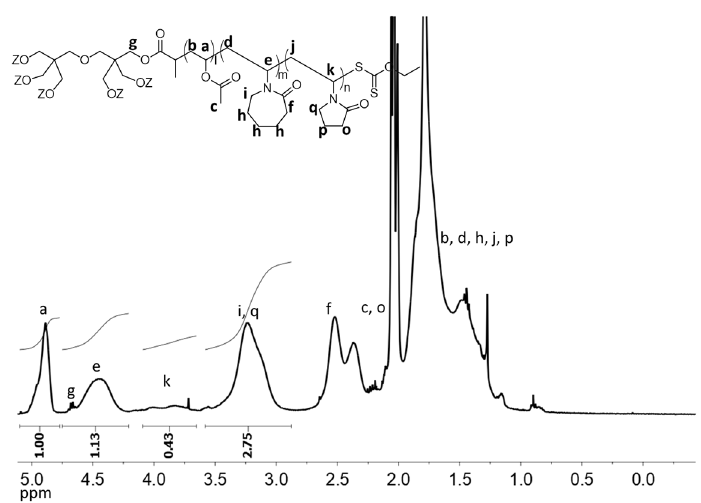
Figure 8. 1 H NMR spectrum (400 MHz) in CDCl 3 of star-shaped (PVAc- b -(PNVCL- co -PNVP)) 6 block copolymers. Sample (PVAc 30 - b -(PNVCL 28 - co -PNVP 17 )) 6 , M n GPC = 42,290 g/mol, Ð = 1.1 (Table 4, Entry 2).